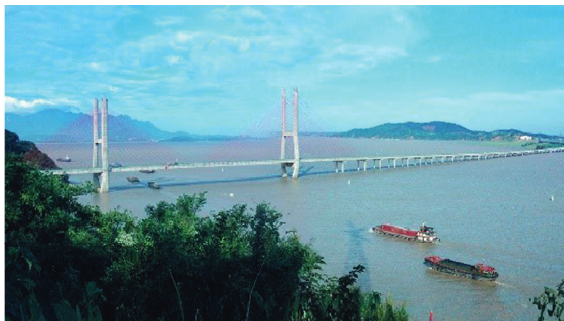
Figure 1: View of Poyanghu Bridge.